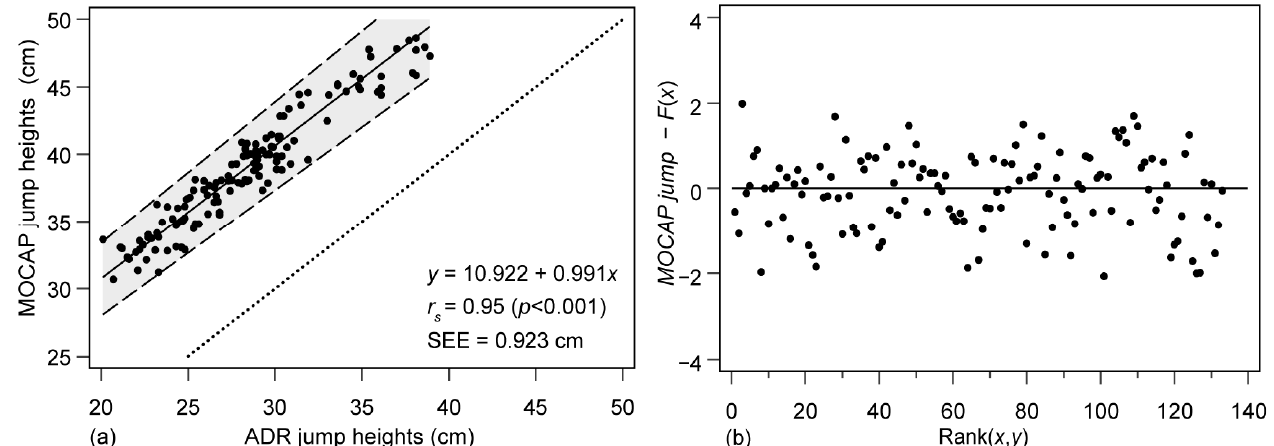
Figure 3. Correlation analysis between the MoCAP system and the ADR jumping photocell through Passing and Bablok regression and residuals plot. ( a ) The continuous line represents the regression line; the shaded area represents the confidence intervals for 95% of the regression line; the pointed line is the x = y line; r s which represents Spearman’s correlation coefficient; SEE = Standard Error of Estimate; ( b ) Residuals plot. No trends are discernible; thus, linearity is assumed. Observation of the Bland–Altman plot (Figure 4) shows a LoA low of 7.99 cm (95% CI of 7.61–8.37 cm) and a LoA upper of 13.07 cm (95% CI of 12.69–13.45 cm). The systematic error found is 10.53 cm, with no proportional error provided (slope = 0.026, p = 0.29). The maximum allowable differences were determined as ± 19.3 cm, with lower and upper LoA included within this range (not in Figure 4).